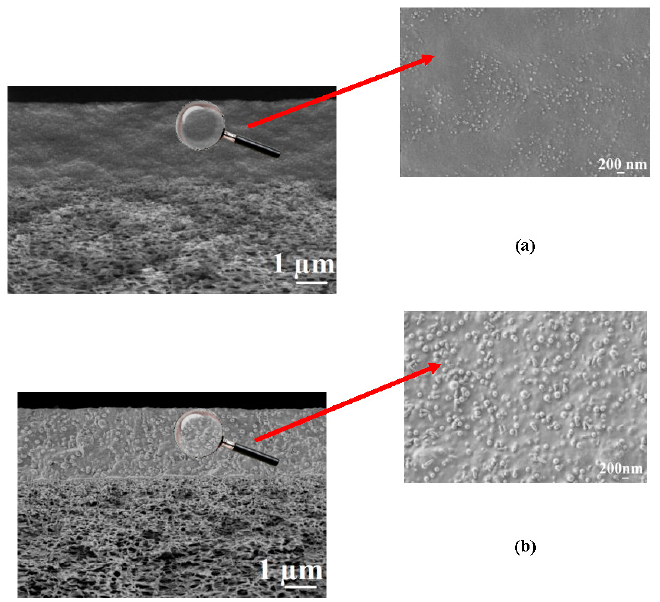
Figure 4. The SEM micrographs of the cross-sections for ( a ) CS-PAN/UPM-20 and ( b ) CS-PS/UPM-20 membranes at different magnifications.